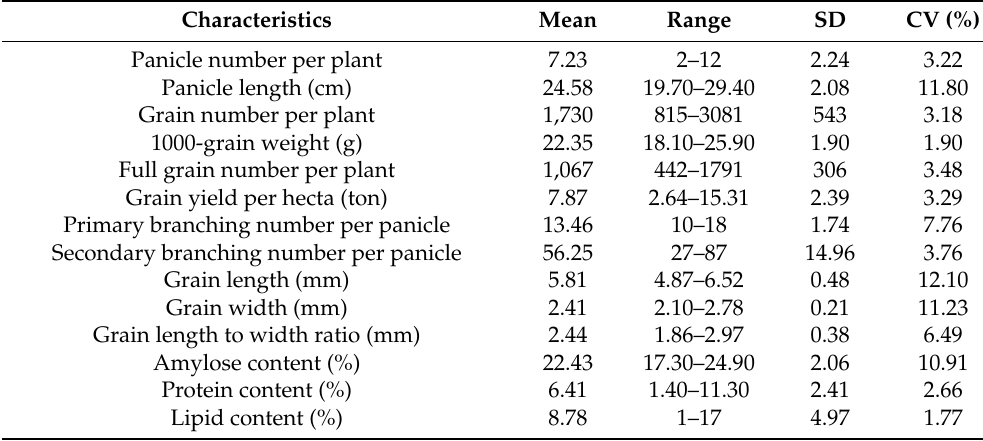
Table 2. Variability of phenotypic